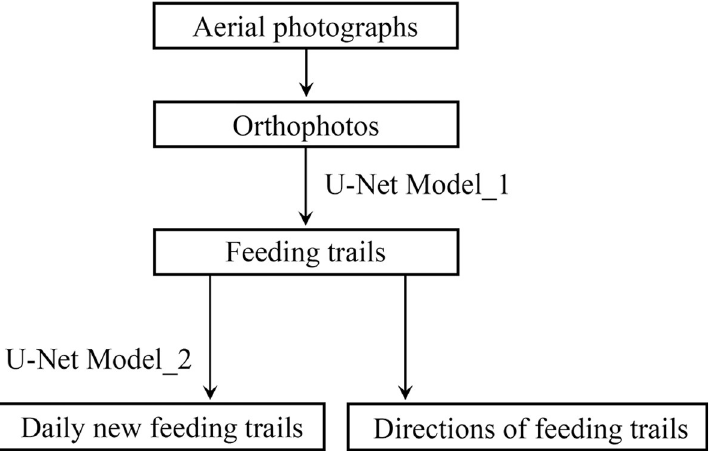
Fig 1. Flowchart of the proposed method. In this paper, “daily new feeding trails” were defined as the feeding trails that were made after the image acquisition with UAV on a certain day and before the next image acquisition on the following day. Furthermore, “Model_1” and “Model_2” were developed by transfer learning from U-Net to extract the feeding trails and the daily new feeding trails, respectively.